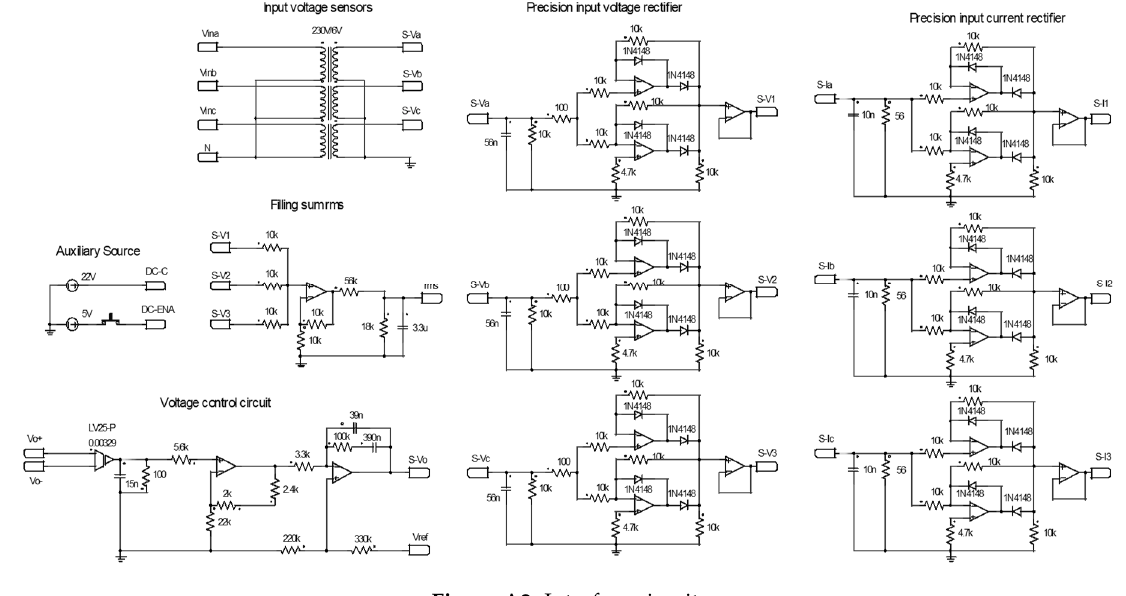
Figure A2. Interface circuit.